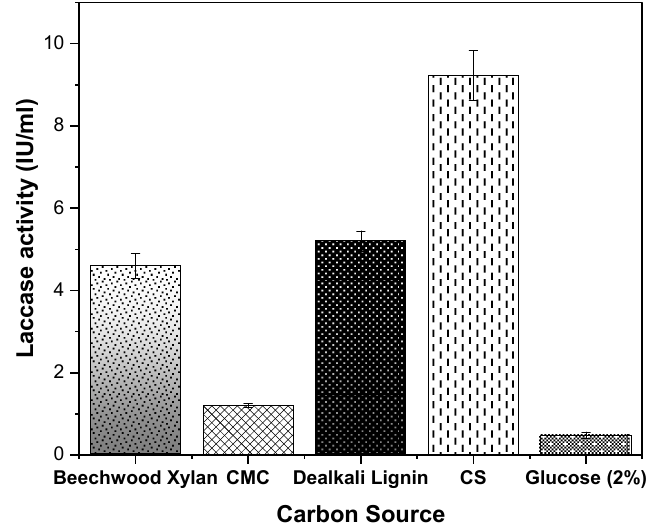
Figure 7. Laccase production in the evolved population of Geobacillus sp. strain WSUCF1 (eWSUCF1) at 60 °C, pH 7.0, and agitation speed of 150 rpm, after 10 days of incubation with 0.5% ( w/v ) unprocessed corn stover (CS) as the carbon source, in the presence of different carbon sources as inducers. Here, CMC = Carboxymethyl cellulose, IU = International Units. Note: All the experiments were performed in triplicates, with data averaged and presented as the mean ± standard deviation (SD).